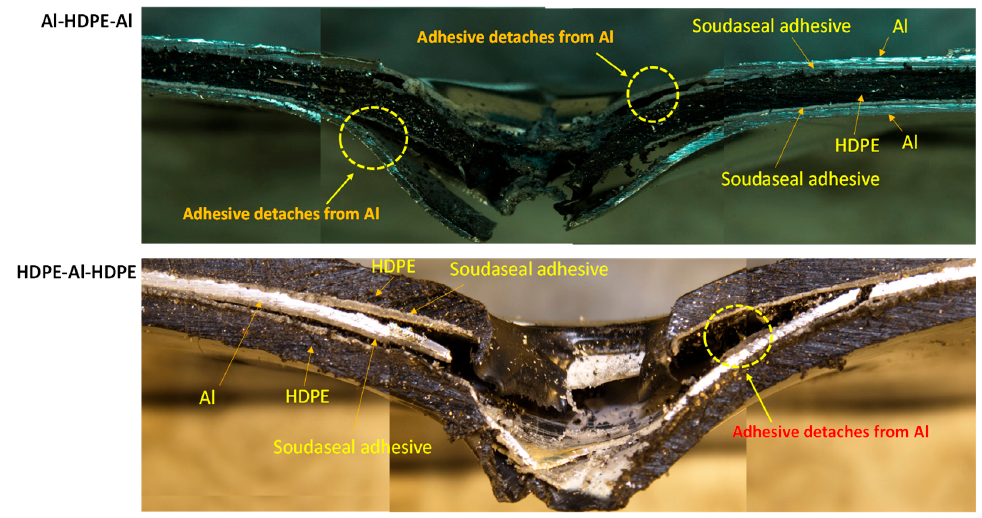
Figure 13. Cross-sectional view of the failure modes of tri-layer laminates under the hemispherical indenter.